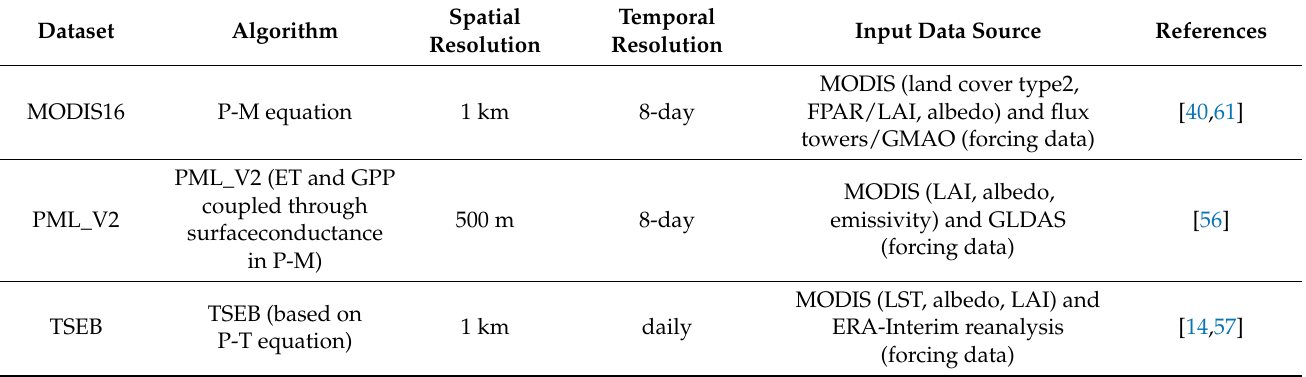
Table 1. Characteristics of three remote-sensing ET datasets used in this study. P-M: Penman–Monteith; GPP: gross primary production; P-T: Priestly–Taylor; FPAR: fraction of photosynthetically active radiation; GMAO: Global Modeling and Assimilation Office; GLDAS: Global Land Data Assimilation